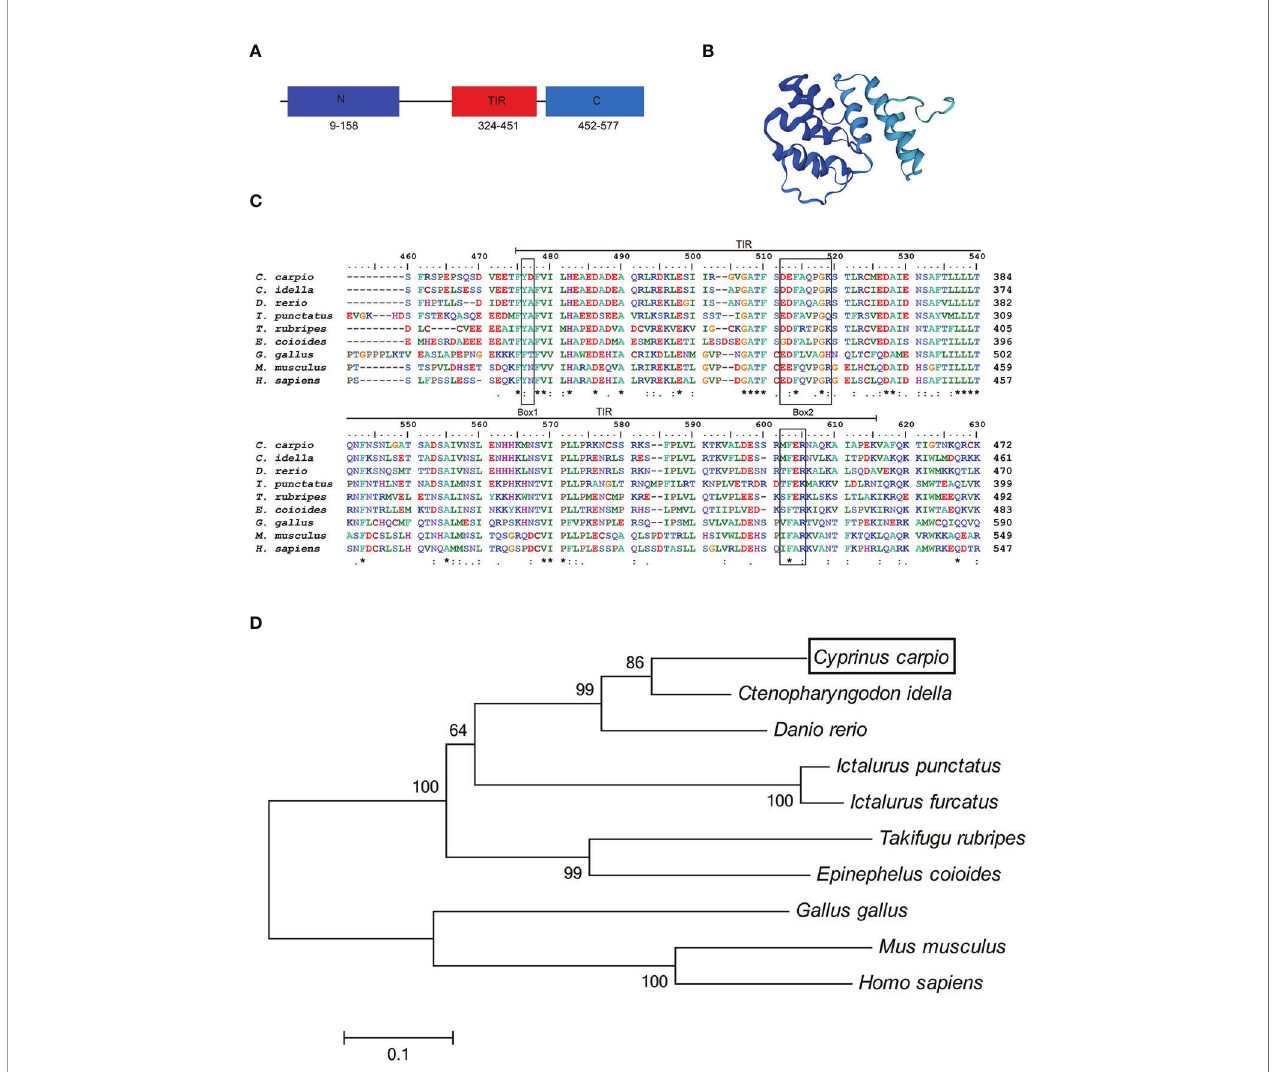
FIGURE 1 | Alignment of TRIF TIR domain sequences and phylogenetic tree. (A) A schematic diagram showing the domain architecture of common carp TRIF. (B) Modeled three-dimensional structure of common carp TRIF shown as a cartoon. (C) The sequences were aligned using the Clustal W method. The identical, conserved, and highly conserved substituted amino acid residues were indicated in (*), (.), and (:) respectively. The three boxes of the TIR domain were outlined in black. (D) Phylogenetic analysis of TRIF amino acid sequences. The phylogenetic tree was constructed using amino acid multiple alignments generated by the neighbor-joining method within the MEGA 6.0. program. Black box denoted carp TRIF. The GenBank accession numbers of these sequences are listed in Supplementary Table 2 . A “ * ” represents amino acid residues identical among all the nine species in the designated site. One "*" represents amino acid residues identical among all the nine species in the column. "**" or “ **** ” indicates that the amino acid residues of the two or four consecutive sites are